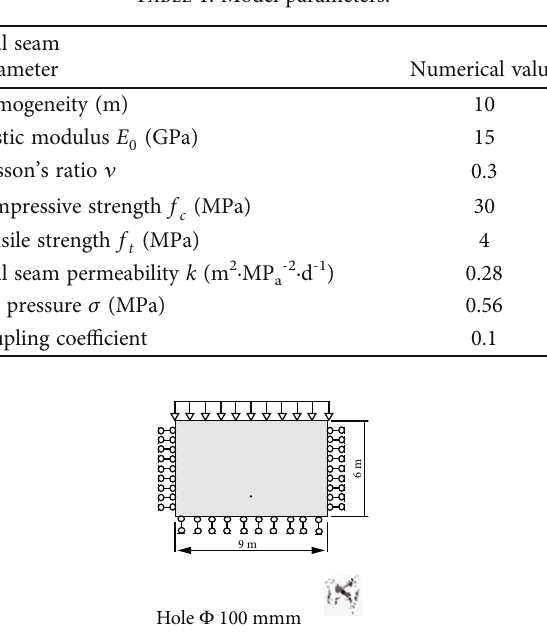
Figure 1: 100-mm maximum principal stress for boreholes.